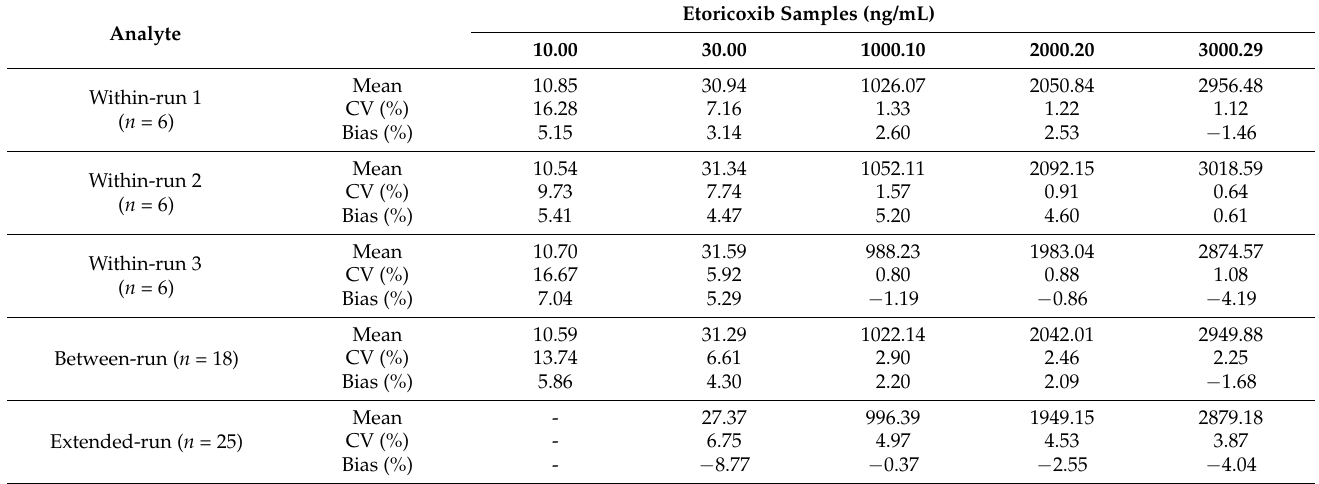
Table 2. Within-, between- and extended batch-run precision and accuracy